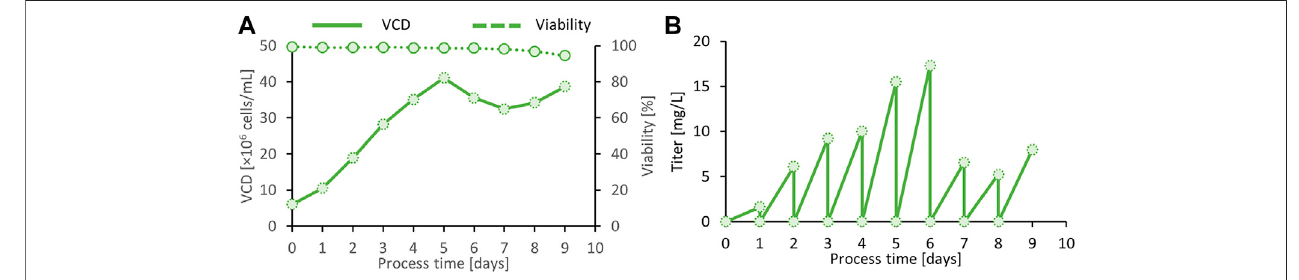
FIGURE 6 | Viable cell density (VCD) and viability of the fi nal clone C11 producing the SARS CoV-2 spike protein in semi-continuous perfusion mode (A) . Daily harvest titer was measured by a quantitative ACE-2/anti-His sandwich ELISA (B) .